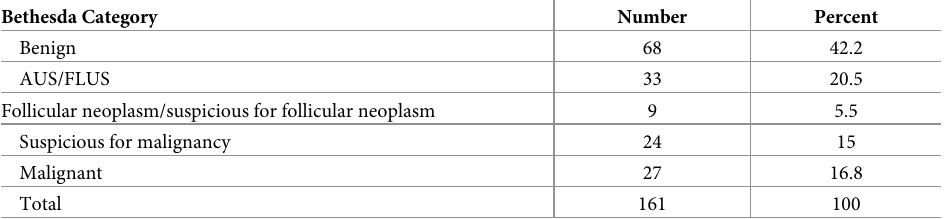
Table 2. The Bethesda reporting system for thyroid cytopathology categories of 161 thyroid nodules. Bethesda